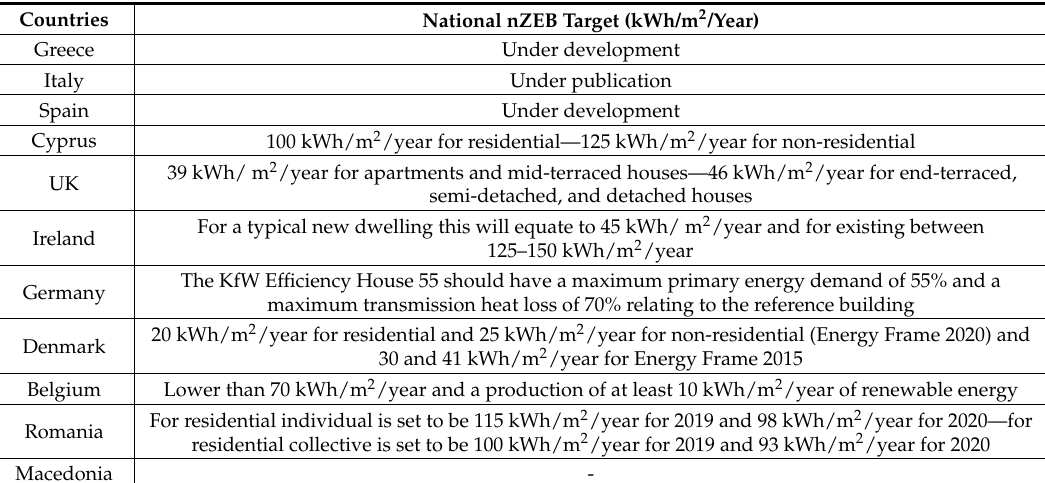
Table 2. National Definition and Targets for nZEB in the countries, source: